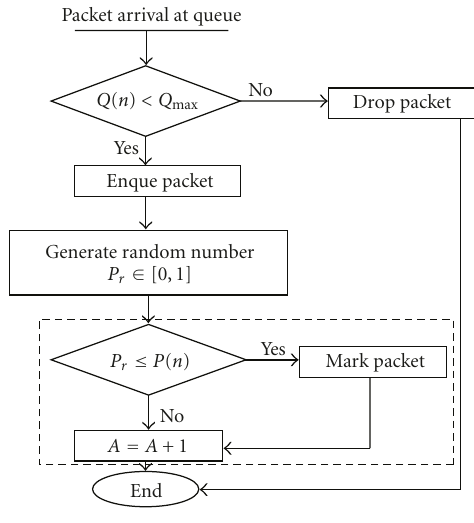
Figure 2: Packet arrival